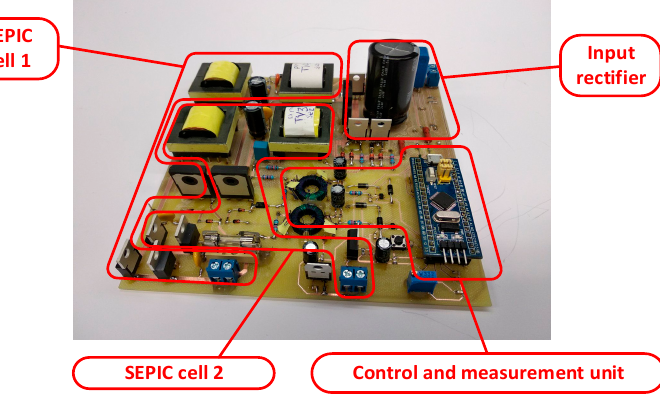
Figure 17. Photo of the experimental converter prototype with two SEPIC cells. Table 4. Main parameters and components of the experimental converter.